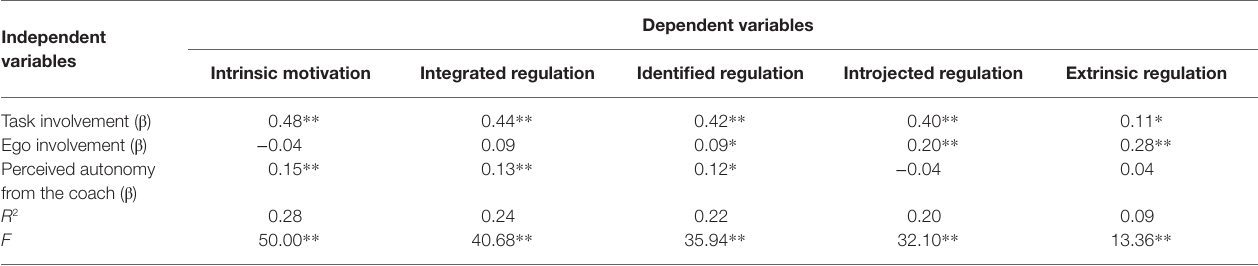
TABLE 3 | Regression analysis with intrinsic motivation, integrated-, identified-, introjected- and extrinsic regulation as the dependent variables, and task- and ego involvement and perceived autonomy support from the coach as the independent variables. Independent